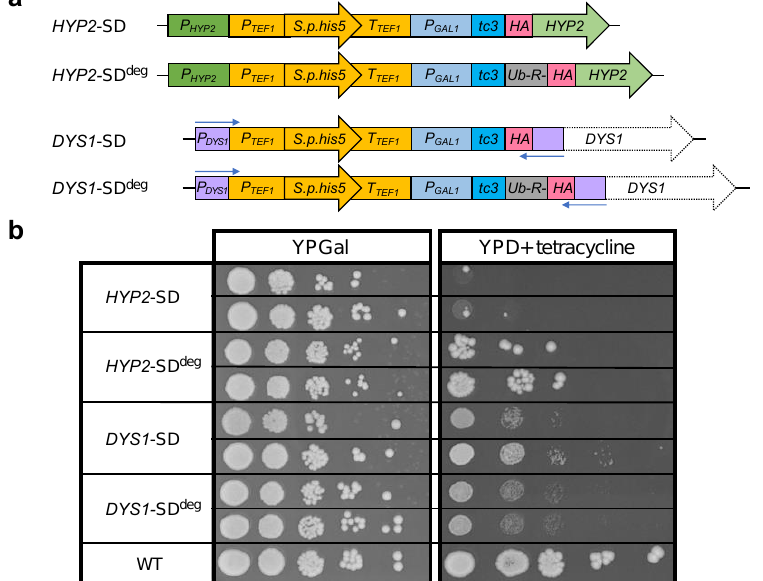
Figure 2. Generation and phenotypes of HYP2 and DYS1 shutdown (SD) strains. ( a ) Schematic representation of constructs used to generate conditional mutants. The constructs were used to replace the endogenous HYP2 or DYS1 loci by one-step gene transplacement in an anb1 ∆ background selecting for complementation of the endogenous his3 mutation by the S. pombe his5 ( S.p.his5 ) gene controlled by P TEF1 and T TEF1 (also known as His3MX6 marker). Two constructs each were generated for HYP2 or DYS1. The latter was generated by PCR using the two HYP2 constructs as templates and long primers (shown here as blue arrows). Conditional expression enabling shutdown (SD) of the resulting genes is controlled, at the level of transcription, by the glucose-repressible P GAL1 promoter and at the level of translation, by three copies of a tetracycline-controlled aptamer (tc3). All encoded Hyp2 or Dys1 proteins have an N-terminal HA tag. To render the resulting proteins metabolically unstable, one construct for each of the two proteins resulted in N-terminal fusions of degradation signals (N-degrons; Ub-R-; superscript deg ) leading to their degradation by the N-end rule pathway. See main text and Methods for further details. ( b ) Shown are spot assays used to evaluate the growth properties of the yeast strains created using the constructs shown in ( a ). Serial 1:10 dilutions were prepared with cells from two independent isolates for the mutants and one for the wild type, pre-grown in complete media with galactose (YPGal) and were spotted onto plates with either galactose or glucose (YPD) as a carbon source. The latter media, in addition, contained 250 µM tet- racycline. Pictures were taken after 3 days of incubation at 30 °C.